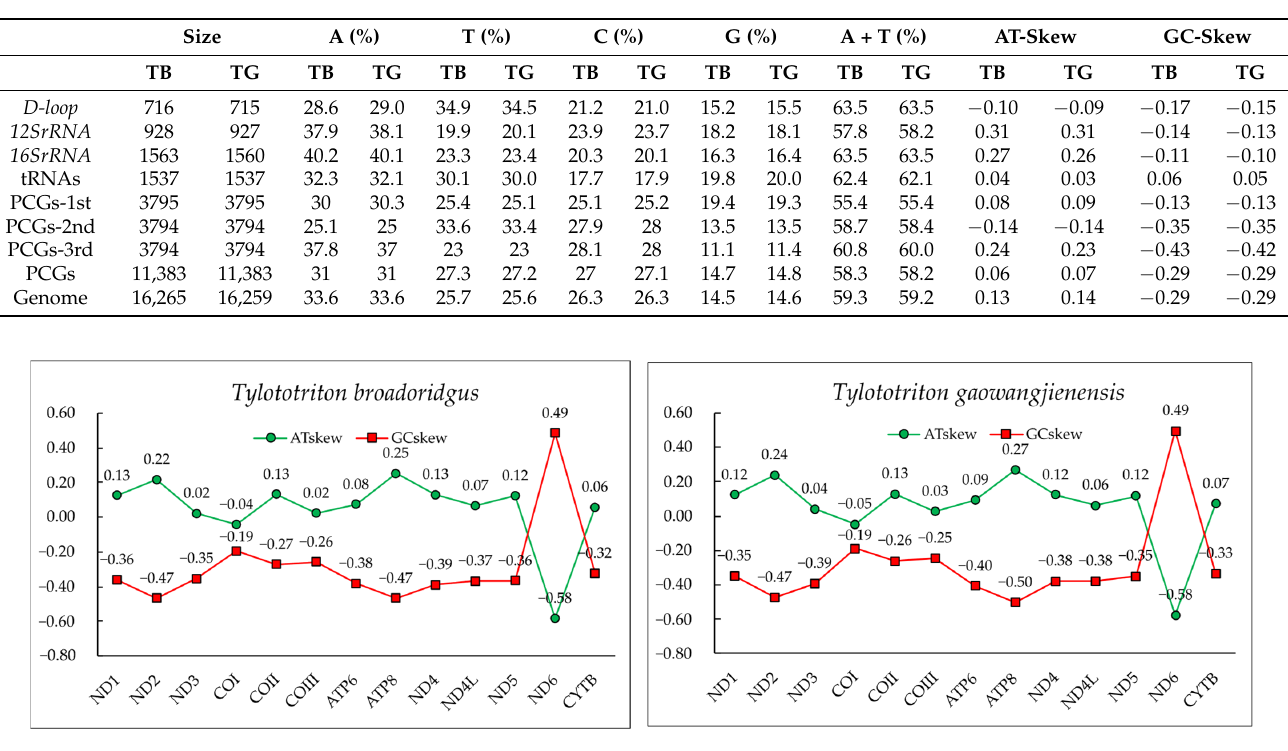
Figure 4. The Ka/Ks ratio of 13 PCGs among 12 species of Tylototriton . 3.4. Characteristics of rRNAs, tRNAs, and the Control Region There were two rRNA genes of both T. broadoridgus and T. gaowangjienensis : the 16S rRNA was located between tRNA Val and tRNA Leu , with corresponding lengths of 1563 bp and 1560 bp, whereas the 12S rRNA was located between tRNA Phe and tRNA Val , with cor- responding lengths of 928 bp and 927 bp (Table 2). The nucleotide composition of the two rRNAs were similar, and the AT-skews were positive and the GC-skews were negative for the two species (Table 3). The mitogenomes of both T. broadoridgus and T. gaowangjienensis contained 22 tRNA genes; of which, eight genes, including tRNA Gln , tRNA Ala , tRNA Asn , tRNA Cys , tRNA Tyr ,